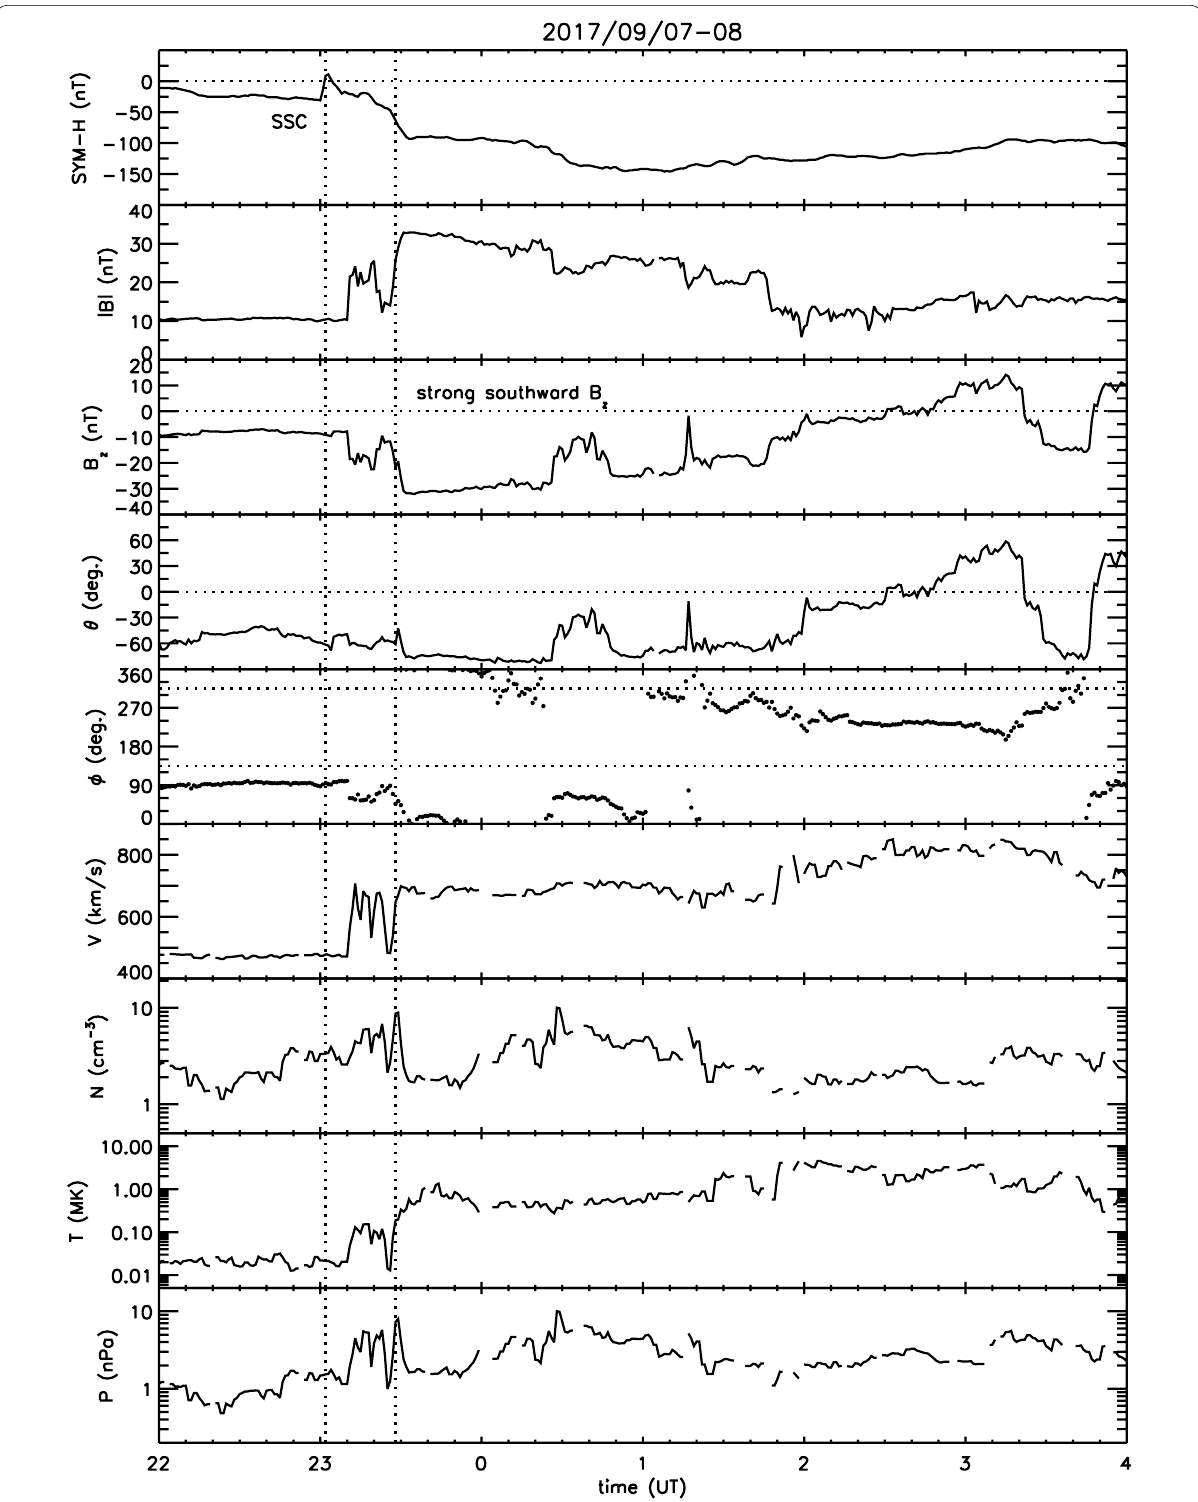
Fig. 11 One-minute data of SYM-H index and solar wind parameters of the 7–8 September 2017 geomagnetic storm. The two dotted vertical lines show the time of the SSC and the start of the strong southward B